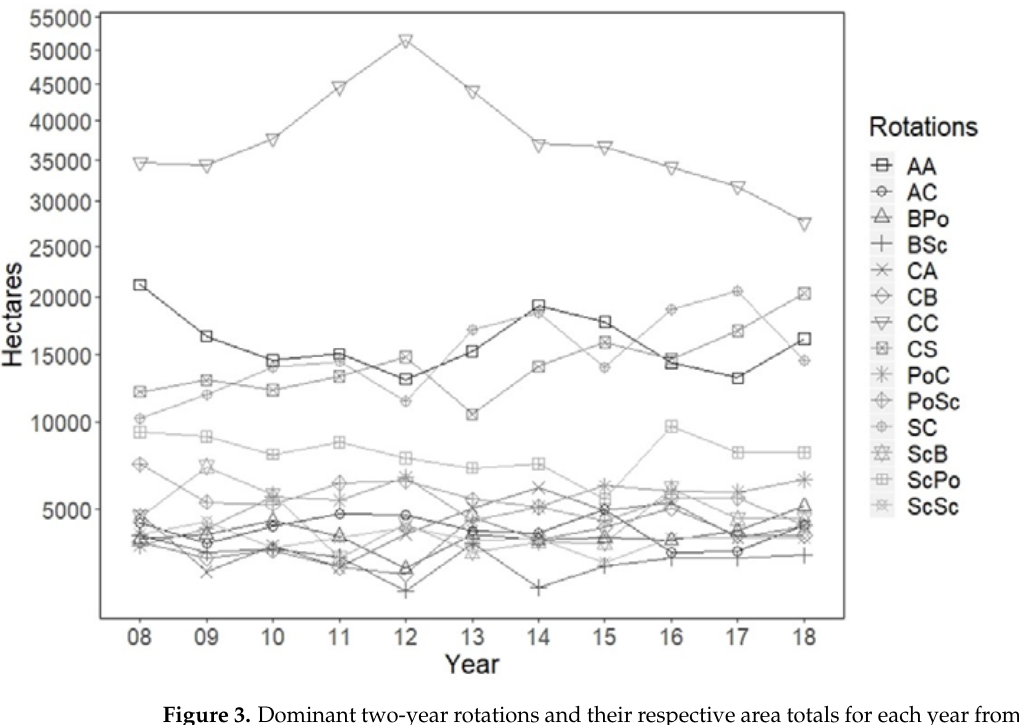
Figure 3. Dominant two-year rotations and their respective area totals for each year from 2008 to 2018. Total hectares on the Y axis are expressed with log scale. The following abbreviations correspond to the crop grown; C = corn, A = alfalfa, S = soybean, Sc = sweet corn, Po = potato, B = beans. Table 4. Most common three-year rotations and their respective average hectare totals and percent coverage of agricultural land in the WCS. Standard deviation indicates the extent of deviation from the mean each rotation has; the CV is the coefficient of variation of annual average variability across all years; the slope, R 2 , and p -value are from linear regression and indicate the change in hectares planted during the study period, how well this change represents the data, and whether this change is significant. The following abbreviations correspond to the crop grown; C = corn, A = alfalfa, S = soybean, Sc = sweet corn, Po = potato, B = beans. Rotations Mean Hectare % Ag Land St Dev CV Slope R 2 p -Value CCC